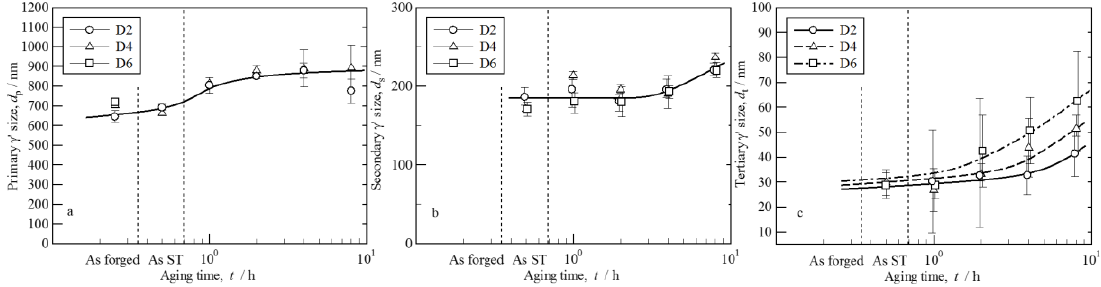
Figure 6. Changes in the particle size of the primary ( a ), secondary ( b ), and tertiary ( c ) γ ′ particles of ABD alloys following forging, solution treatment, and isothermal aging at 1123 K.